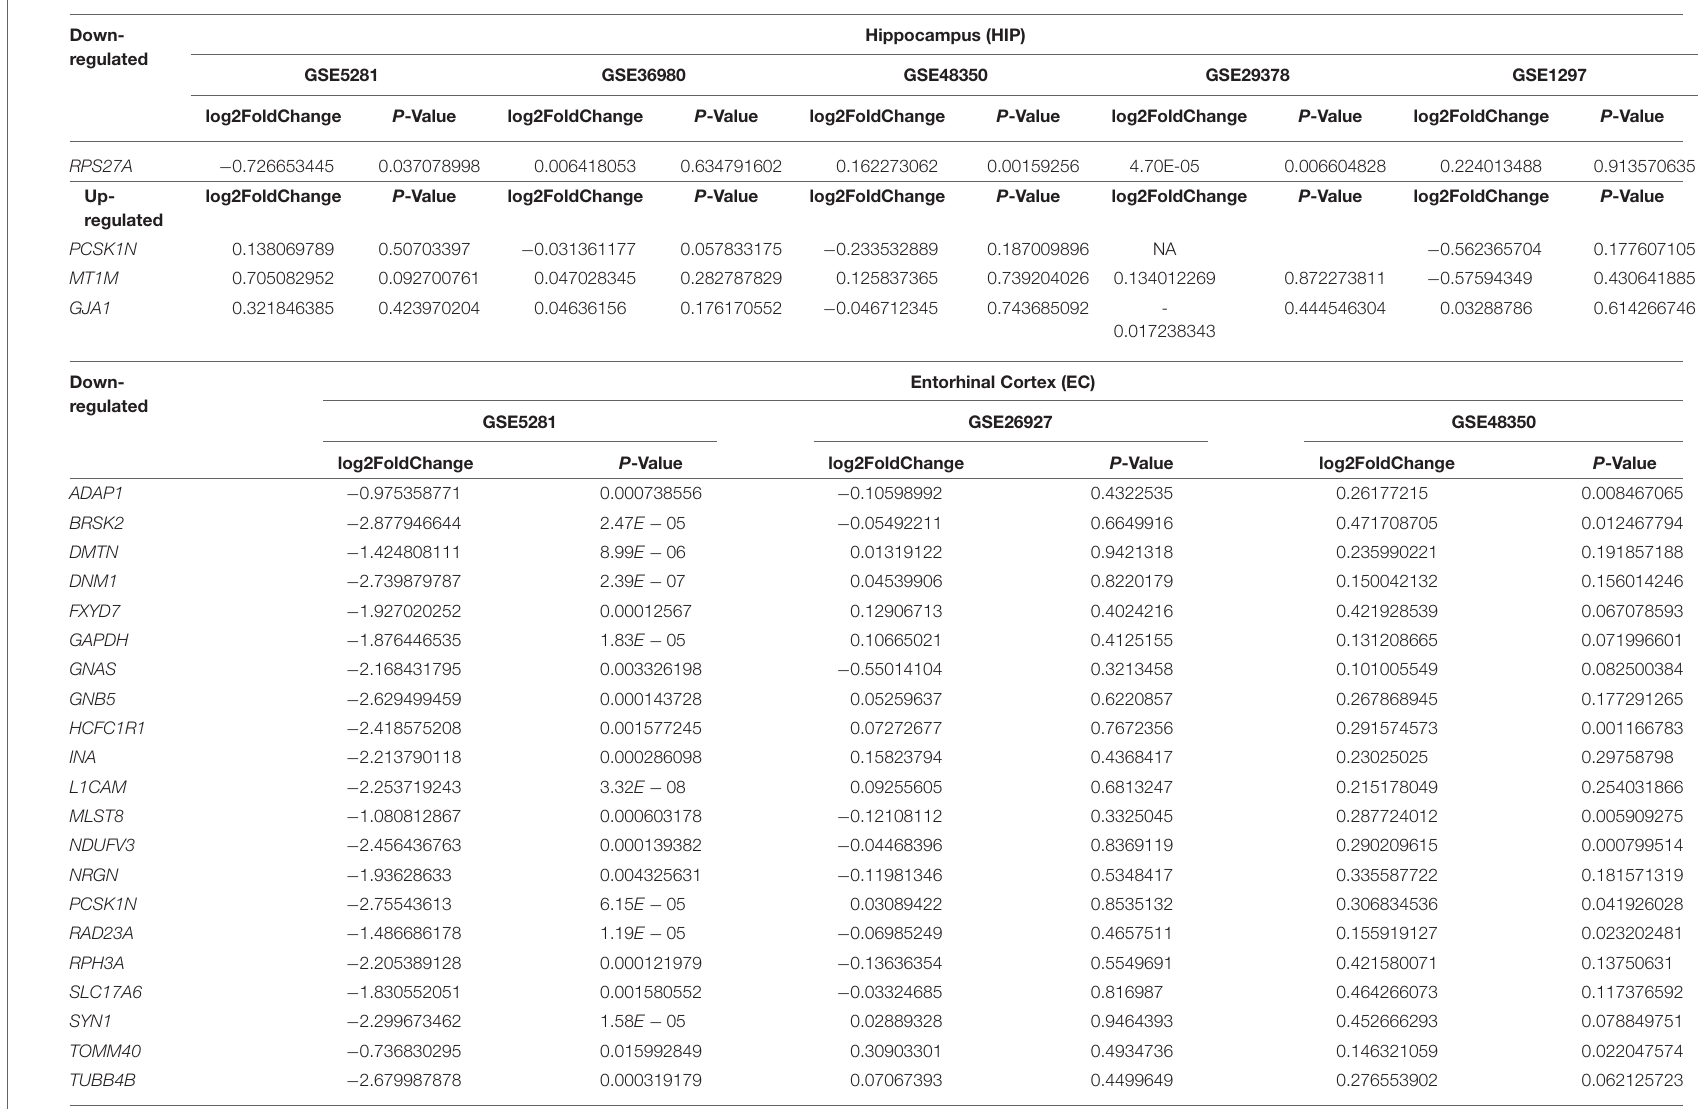
TABLE 5 | The down/up situation of 57 AD-associate genes identified in the meta-analysis in each individual dataset. Down-